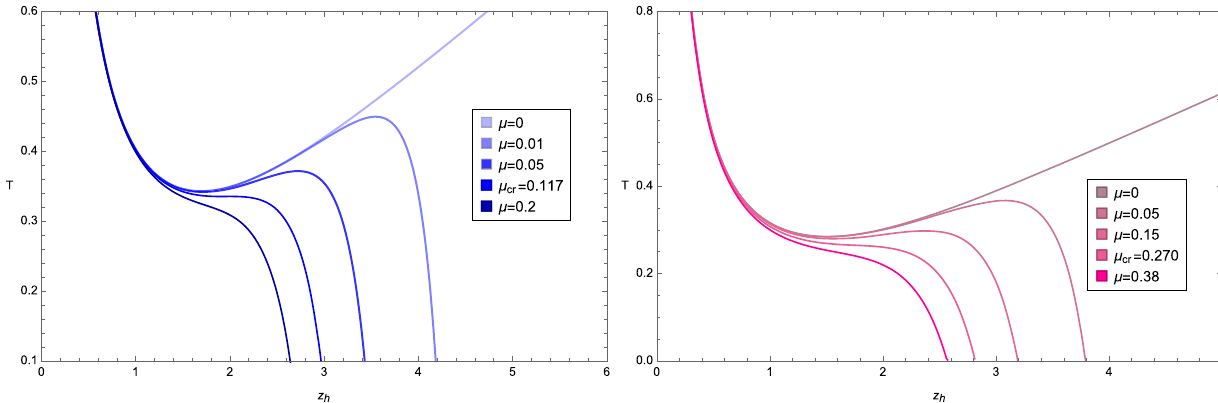
Fig. 1 Temperature as a function of the horizon for isotropic case (left) and anisotropic case, ν = 2 (right) for different values of μ